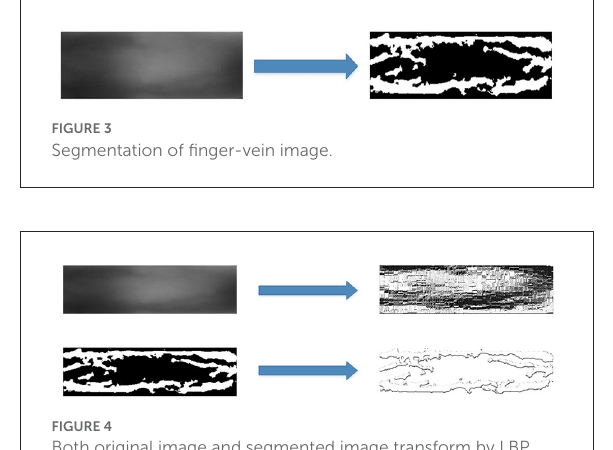
FIGURE4 Both original image and segmented image transform by LBP.